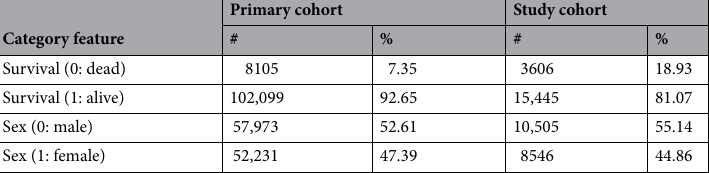
Table 2. Statistical quantitative description of the category features. #: Number of admissions. %: percentage of admissions. Primary cohort full sample: 110,204 admissions. Study cohort full sample: 19,051 admissions.